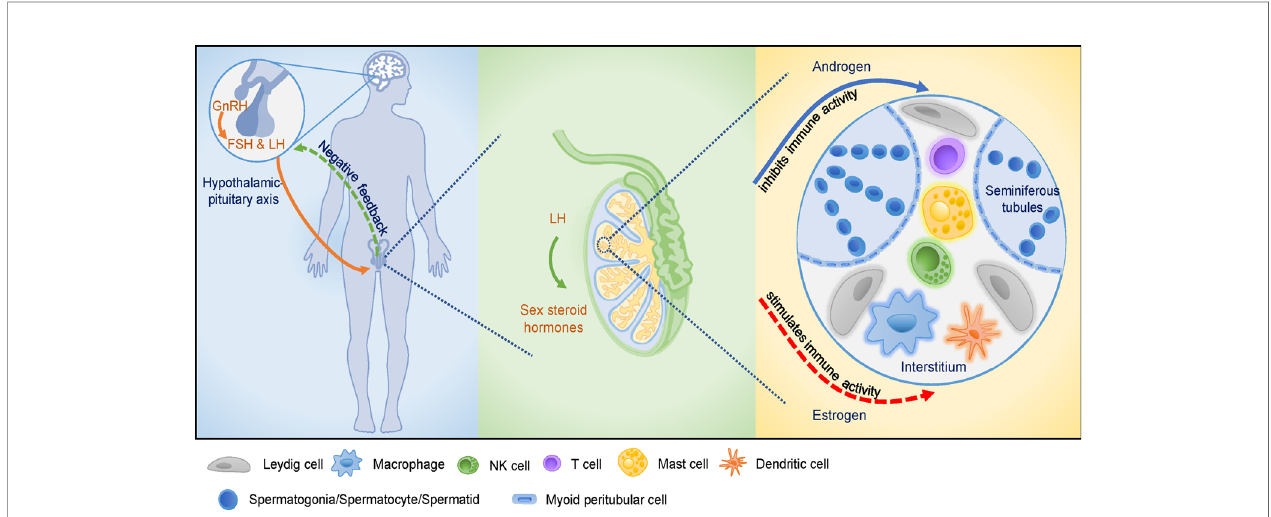
FIGURE 1 | The hypothalamic-pituitary-testicular (HPT) axis and the testicular immune-privileged microenvironment. GnRH stimulates the release of pituitary gonadotropins, induces male reproductive function as well as affects cellular and humoral immune function. GnRH promotes the proliferation of immune cells and modi fi es cytokines production. Pituitary gonadotropins are involved in cellular and humoral immune development. Sex steroid hormones are secreted by the stimulation of LH that acts on Leydig cells in testis. Androgens and estrogens affect male reproductive function via modulation of the immune system and immune response. Various cell types present in the testicular interstitial space, including macrophages, DCs, T cells, NK cells, mast cells, and Leydig cells, providing a unique microenvironment for testicular functions. Androgens play crucial roles in maintaining the integrity of testicular immune-privileged microenvironment (solid arrow), while estrogens seem to play a stimulatory role in testicular immunoregulation which needs further investigations (dotted